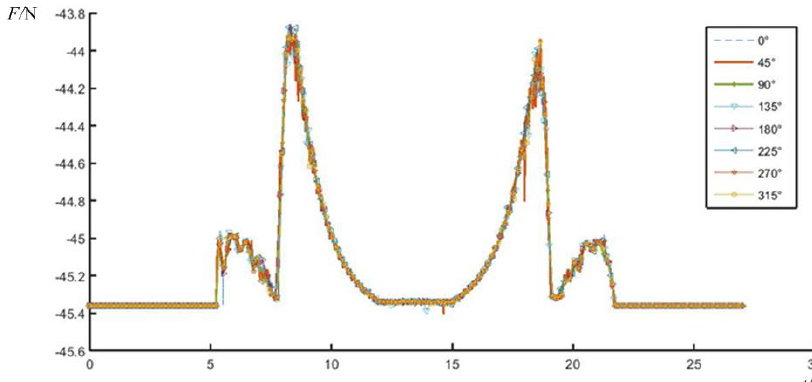
Figure 30. Actuator forces in eight cases.